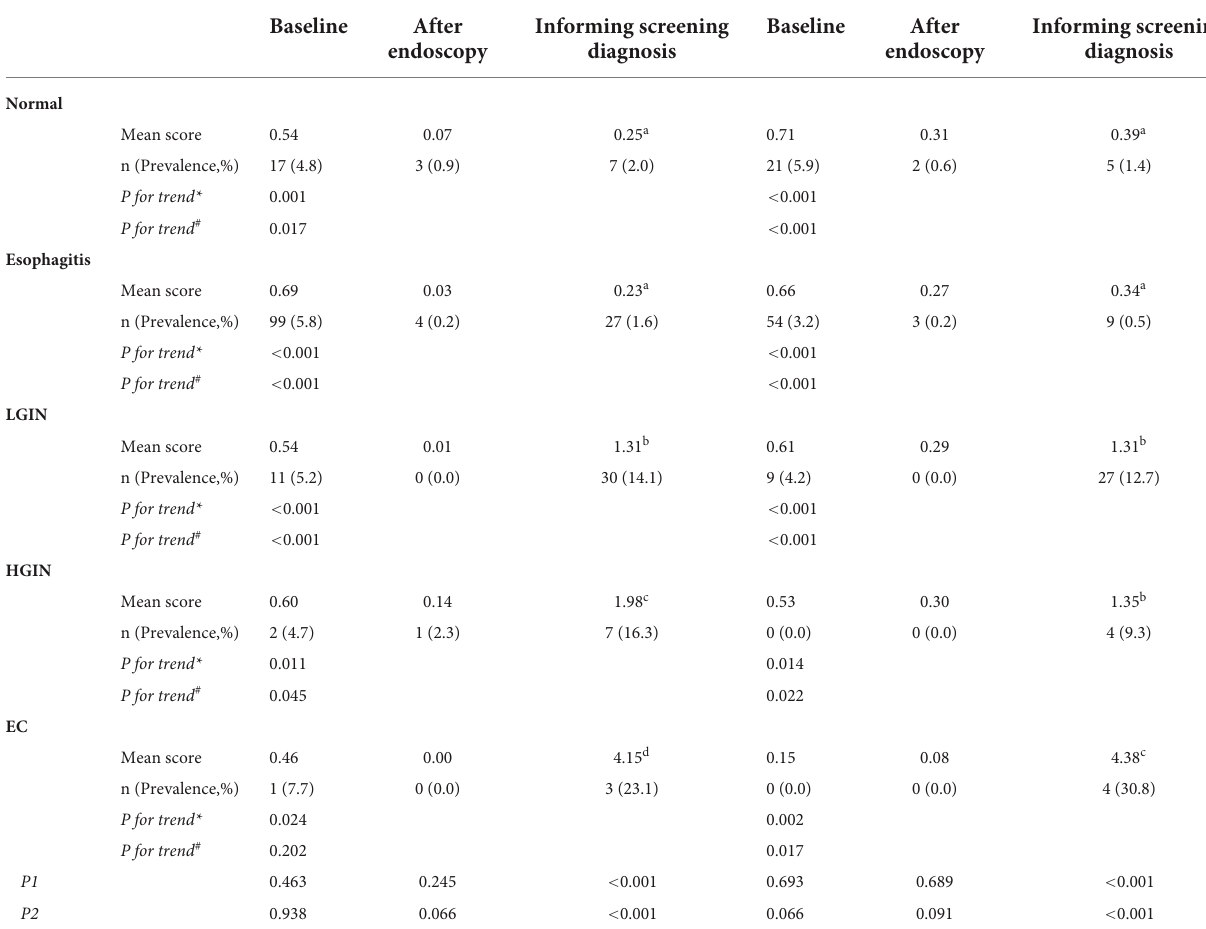
TABLE 2 Anxiety and depression in the screening process, by pathological